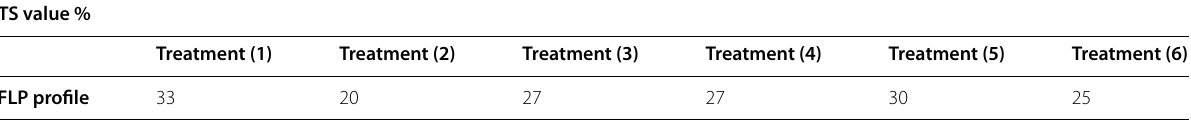
Table 8 Genomic template stability of six Dimocarpus longan regenerated plants and its doner plant according to changes in DNA‑ AFLP fingerprint